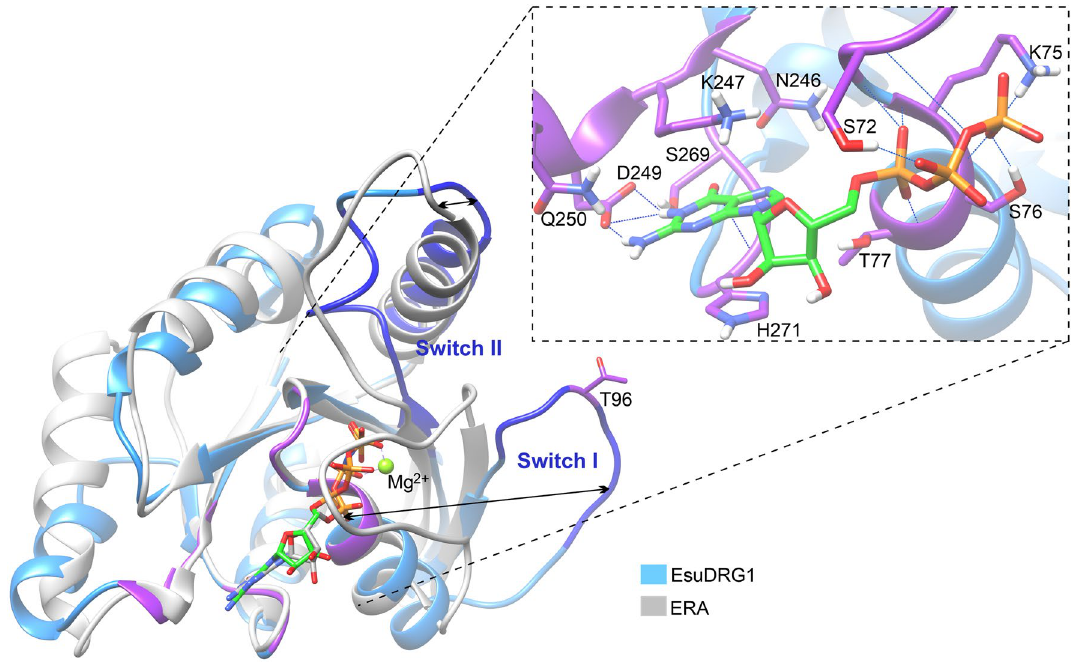
Figure 7. The superimposition of GTP-binding domains from Eunapius subterraneus DRG1 and Aquifex aeolicus ERA protein. Amino acids that are within 4 Å from GTP and highly conserved in the GTPase domain are shown as sticks, and colored purple. Different positions of Switch I and II are represented by arrows. GTP and its analogue are depicted as sticks. GTP docked into the DRG1 binding site using the AutoDock Vina is colored green. Zoomed GTP binding site of DRG1 from Eunapius subterraneus is depicted in the right rectangle. ERA protein from Aquifex aeolicus is crystalized in complex with MgGNP (PDB: